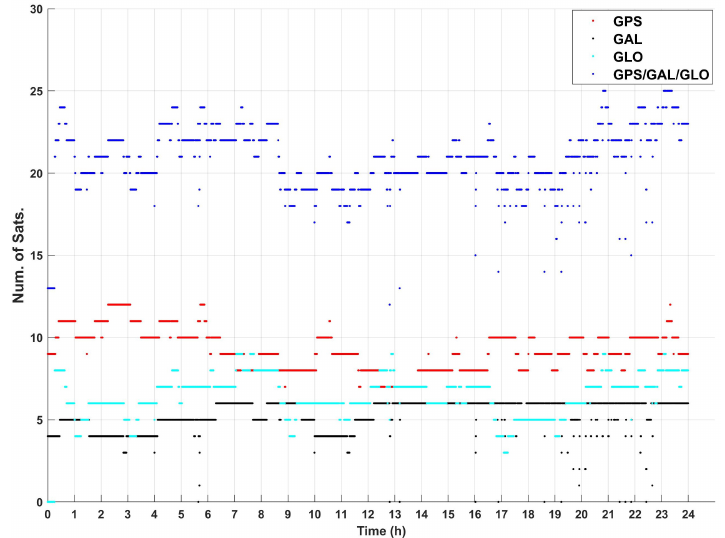
Figure 2. Number of visible